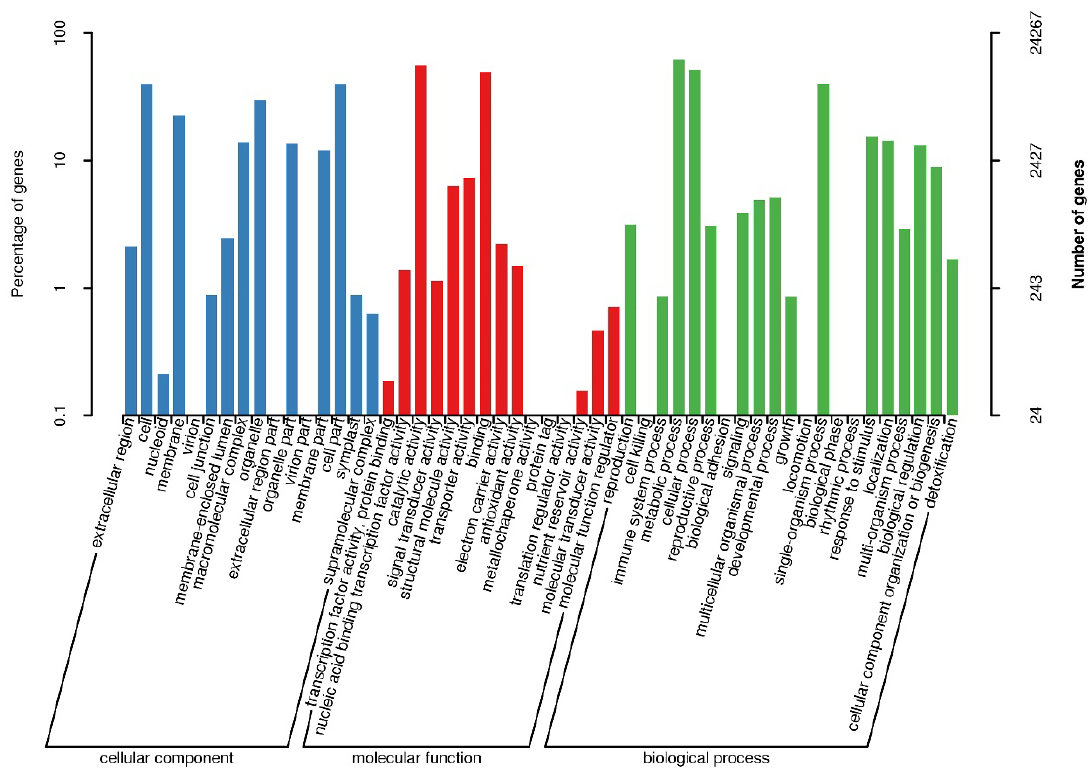
Figure 2. Functional classification of the assembled unigenes of A. miaotaiense based on gene ontology (GO) categories.